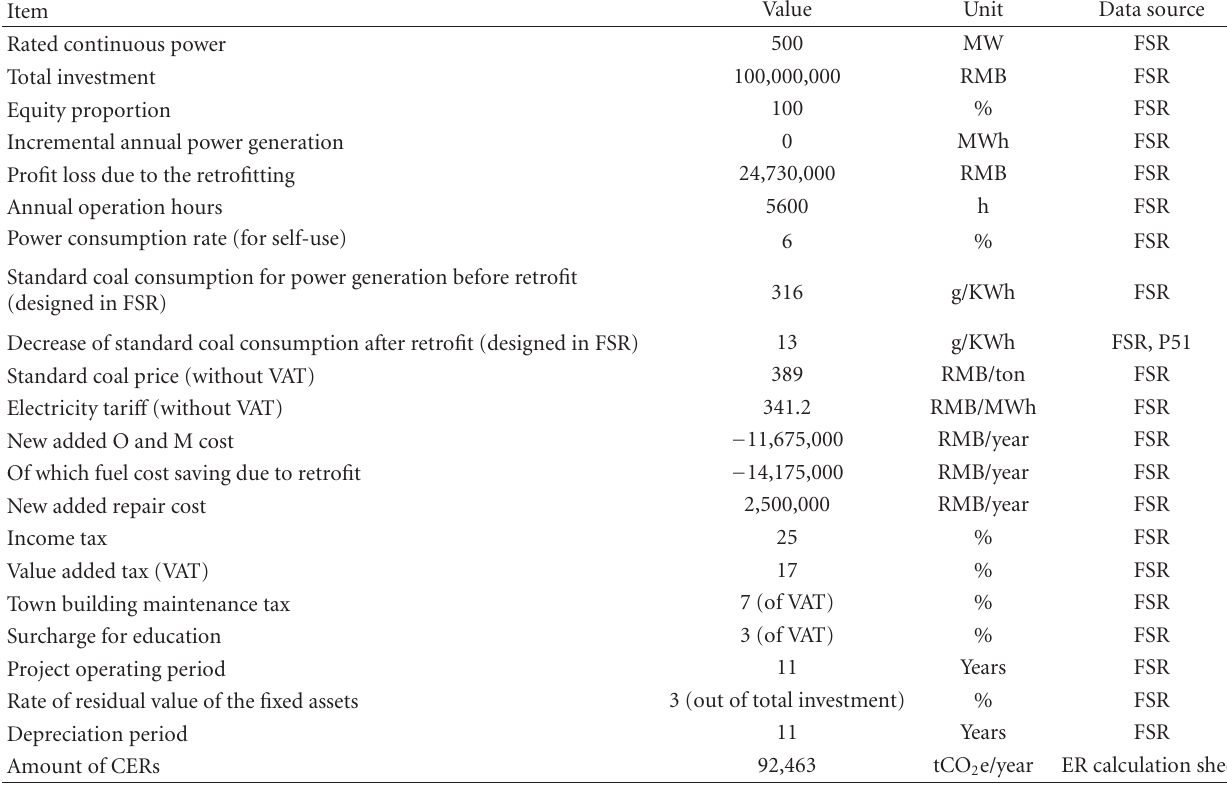
Table 3: The key parameters of the proposed project.